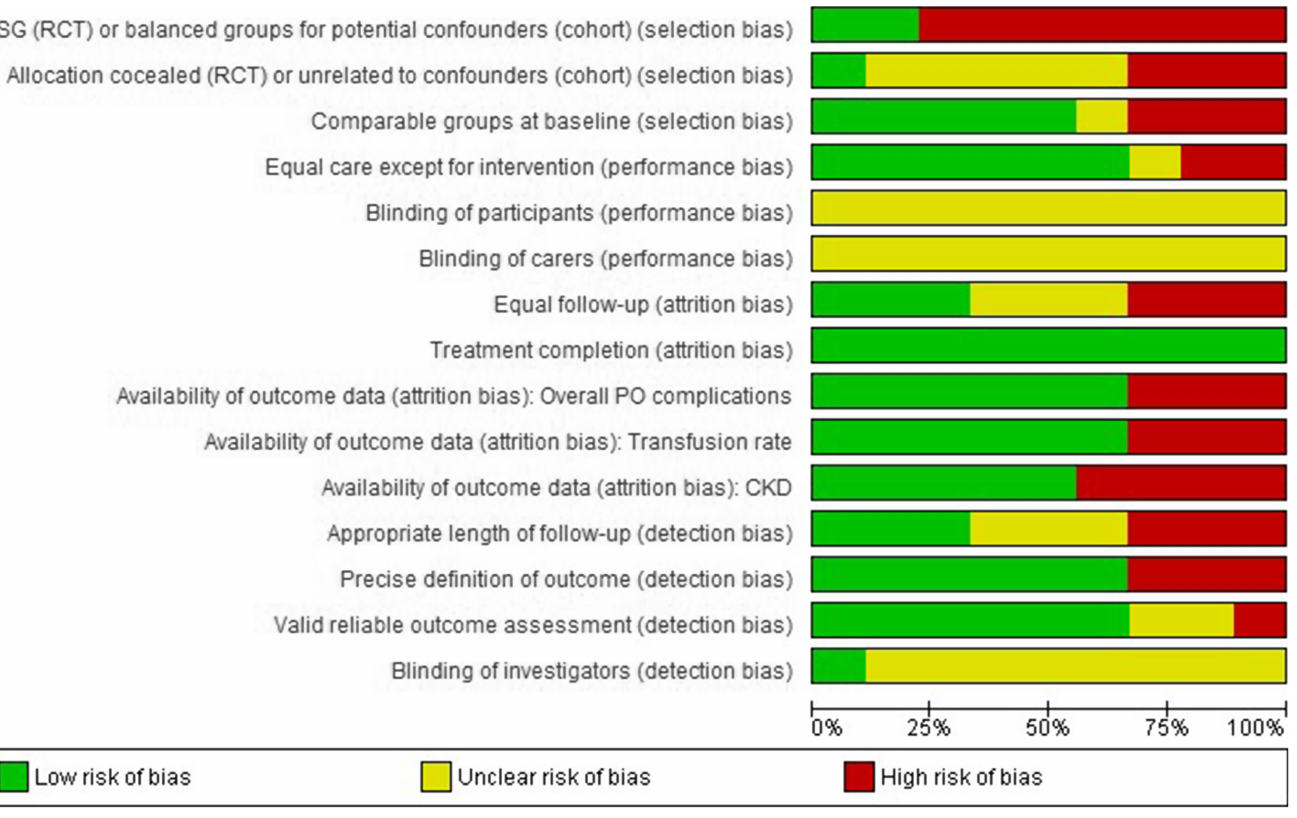
Figure 3. Risk of bias summary of each item presented as percentages across all included studies. RCT, randomized controlled trial; RSG, random sequence